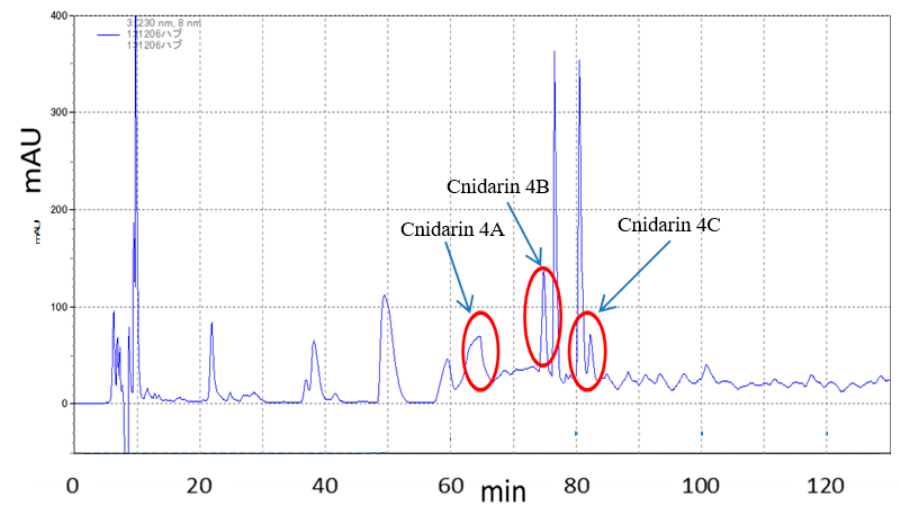
Figure 3. Reversed phased HPLC chromatogram of Chironex yamaguchii nematocyst extracts using Develosil C30 column. Cnidarin 4A ( 1 ), 4B ( 2 ), and 4C ( 3 ) peaks are indicated. Detection is by UV.